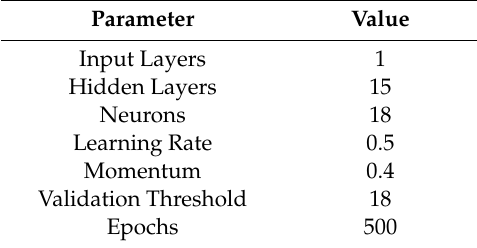
Table 2. Implemented multilayer perceptron (MLP) classifier constraints